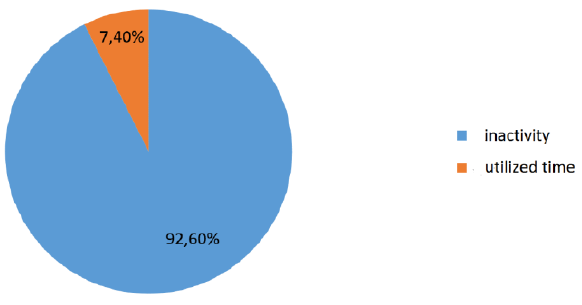
Figure 13: Time utilization of AGV in full operation.